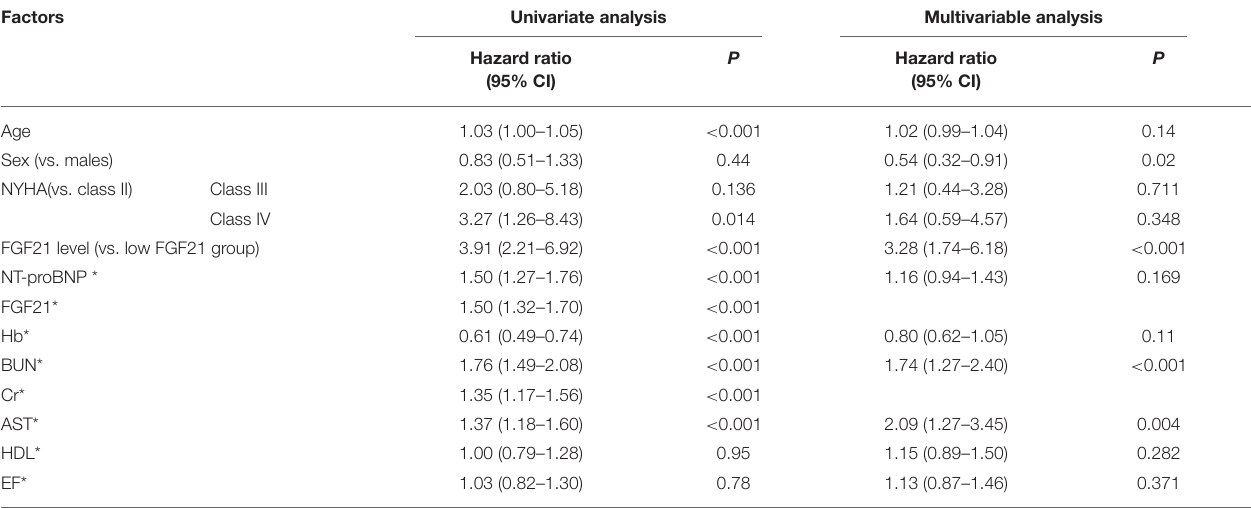
TABLE 2 | Risk factors for all-cause death according to the Cox proportional hazards regression model. Factors